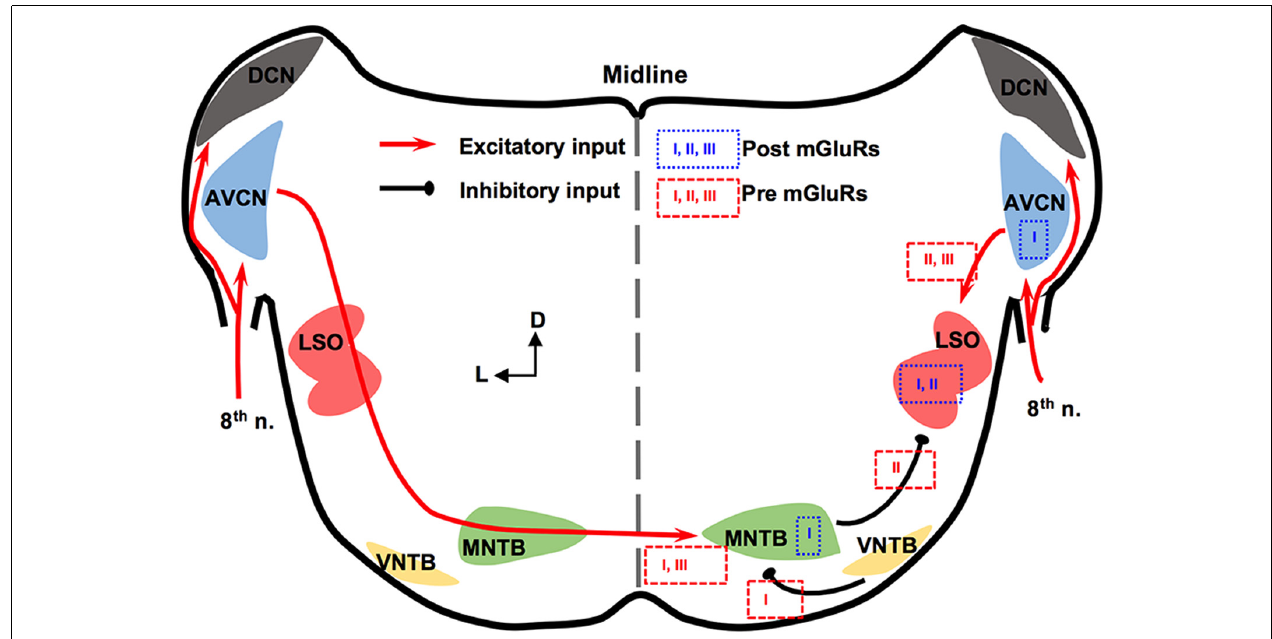
FIGURE 1 | Metabotropic glutamate receptor (mGluR) modulation in the mammalian brainstem interaural level differences (ILD) pathway. Modulation of neuronal properties by mGluRs has been observed at the ILD-coding site lateral superior olivary (LSO), as well as the input nuclei, anteroventral cochlear nucleus (AVCN) and medial nucleus trapezoid body (MNTB). At the LSO, groups I and II mGluRs at the postsynaptic site generate Ca 2+ signaling. Presynaptic group II mGluRs regulate the inhibitory input from MNTB while groups II and III mGluRs regulate the excitatory input from AVCN. At the AVCN, the group I mGluRs facilitate the excitability of bushy cells. At the MNTB, besides facilitating the excitability, the group I mGluRs exert release-mode dependent modulation on both the excitatory and inhibitory inputs to MNTB. Group III mGluRs may also be involved in modulating the excitatory input to MNTB. The text boxes containing the subtypes of mGluRs indicate postsynaptic (within a particular nucleus) or presynaptic (outside of the nucleus)